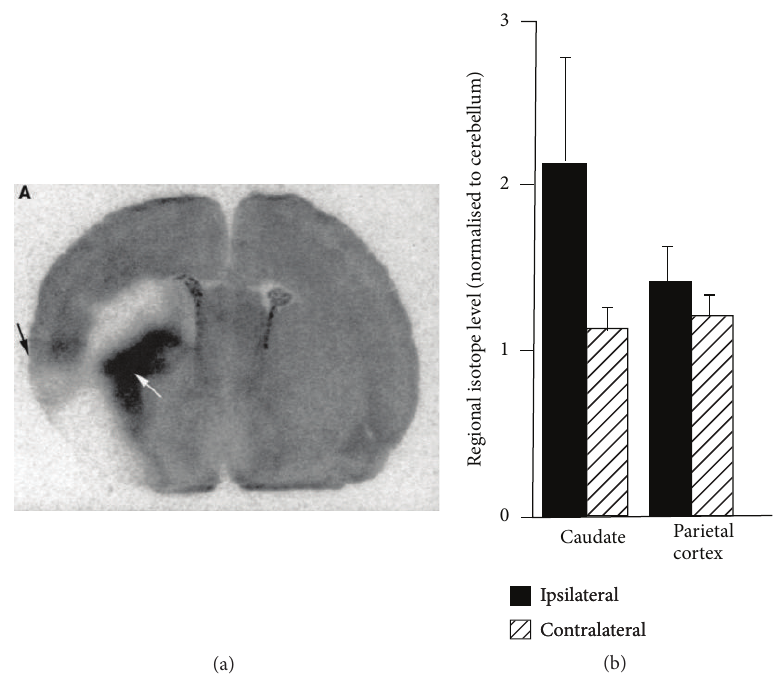
Figure 2: Ex vivo autoradiograms of [ 125 I]CNS 1261 in the caudate nucleus (white arrow) and cerebral cortex (black arrow) of rat brain (a). Quantified regional isotope levels normalized to cerebellum (b). The animals were injected with [ 125 I]CNS 1261 15 min after permanent occlusion of the middle cerebral artery (left hemisphere) and sacrificed 120min later